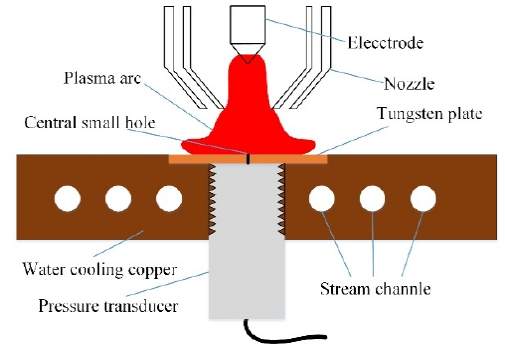
Figure 6. Diagram of measurement structure cross Figure 5. Experimental system of measuring variable polarity plasma arc pressure.